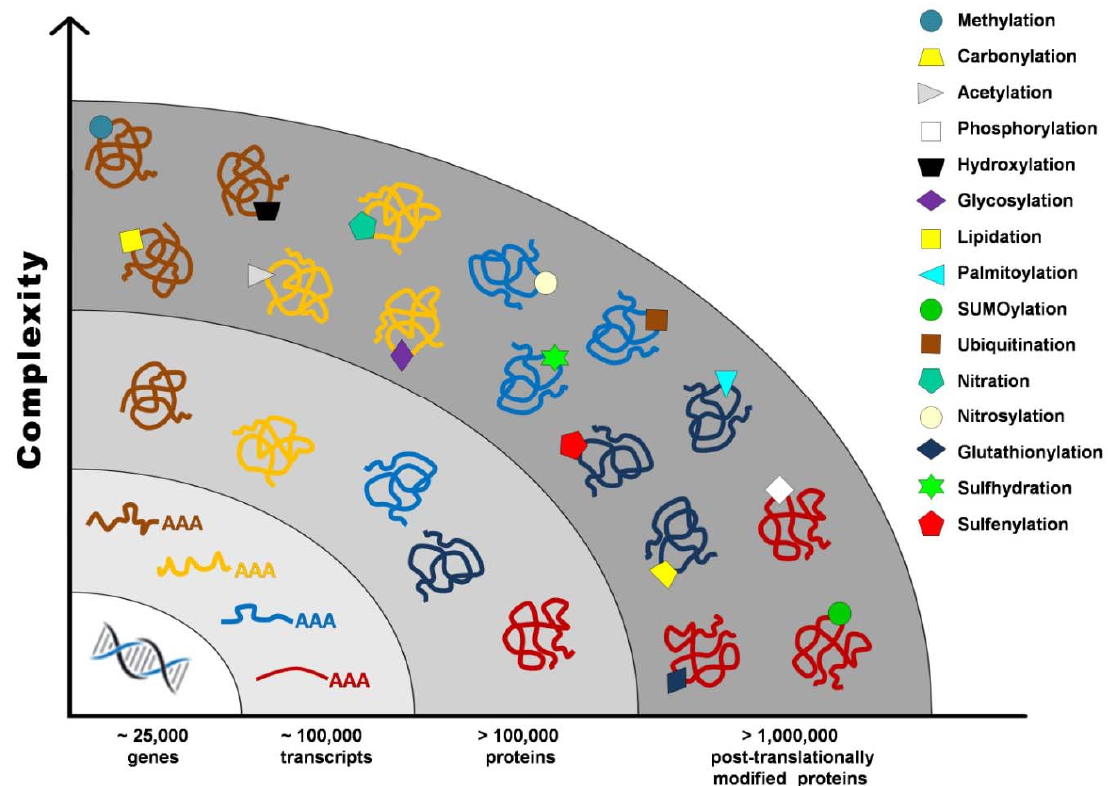
Figure 1. Post-translational modifications increase proteome complexity.